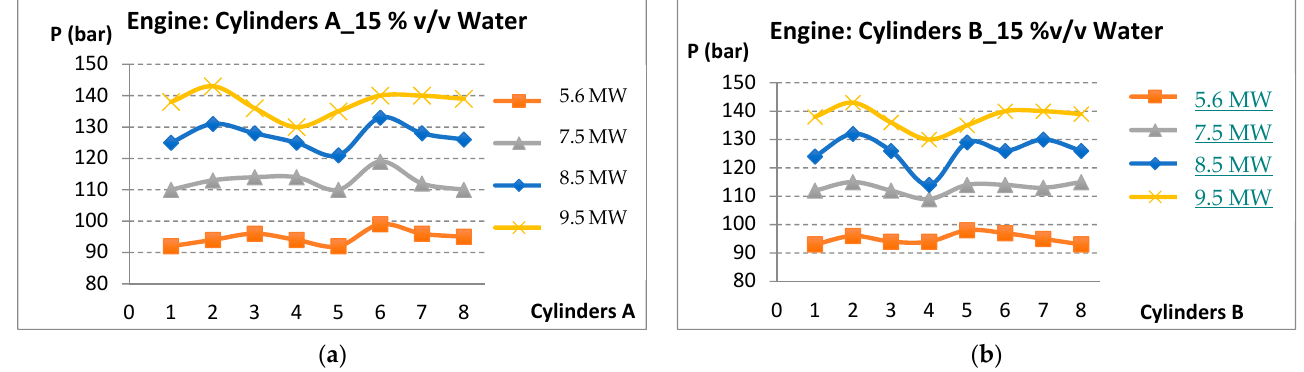
Figure 16. Variation of cylinder pressures in the operational regimes evaluated: ( a ) cylinders on side A; ( b ) cylinders on side B.